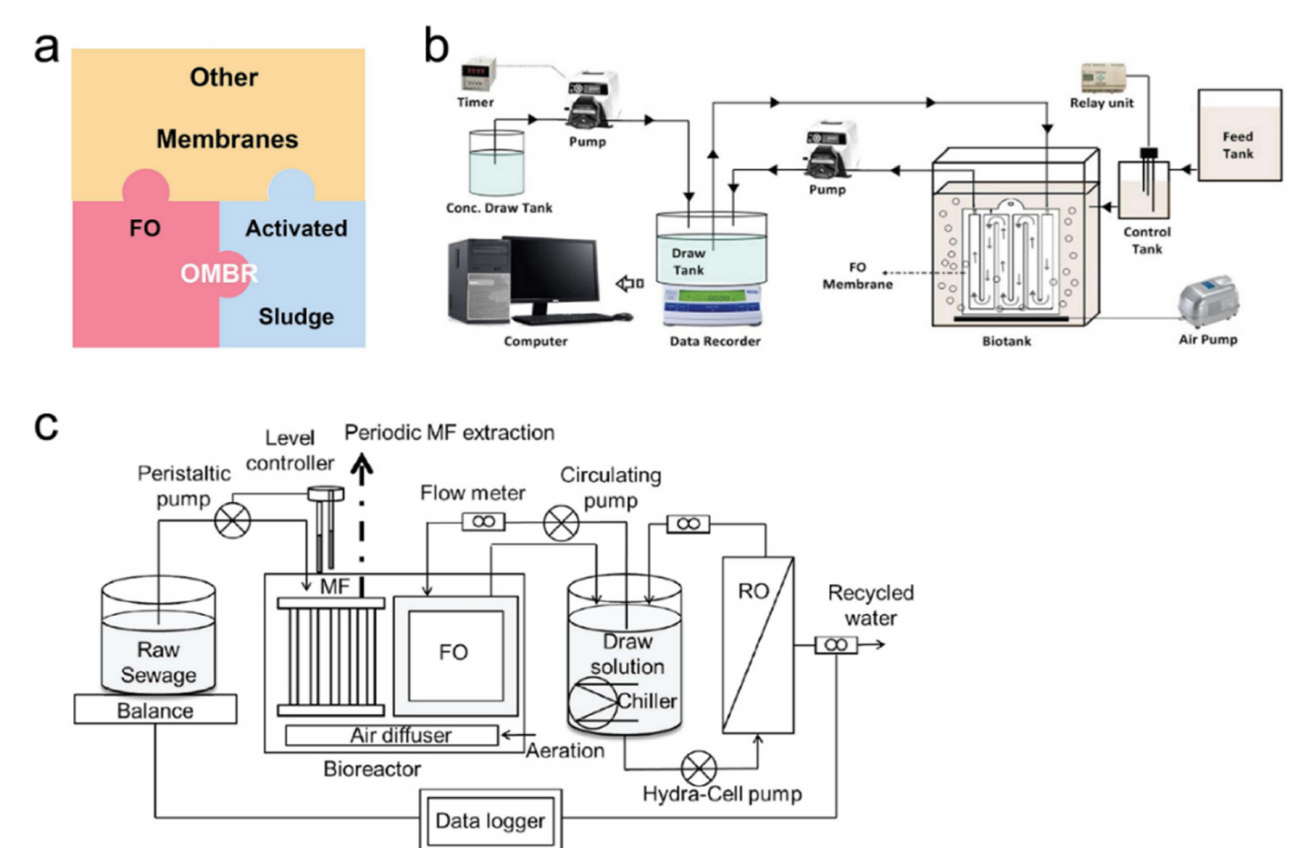
Figure 6. ( a ) Illustration of the integration of OMBR with other membrane technologies, ( b ) the submerged OMBR system, reprinted with permission from [81], and ( c ) the MF-OMBR–RO hybrid system, reprinted with permission from